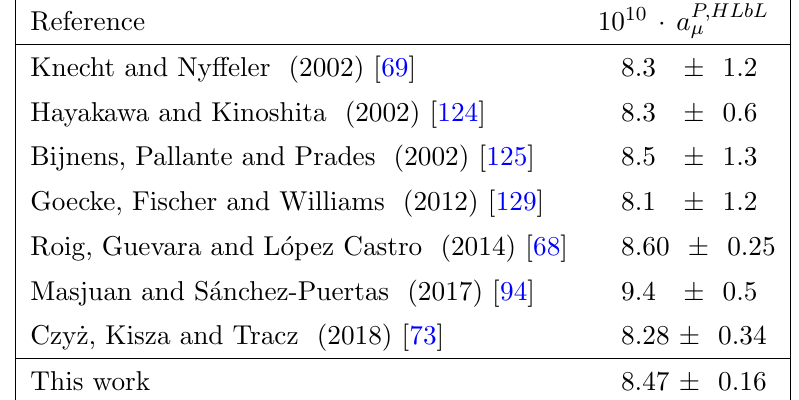
Table 13 . Comparison of di(cid:11)erent predictions for the pseudoscalar-pole contributions to a HLbL